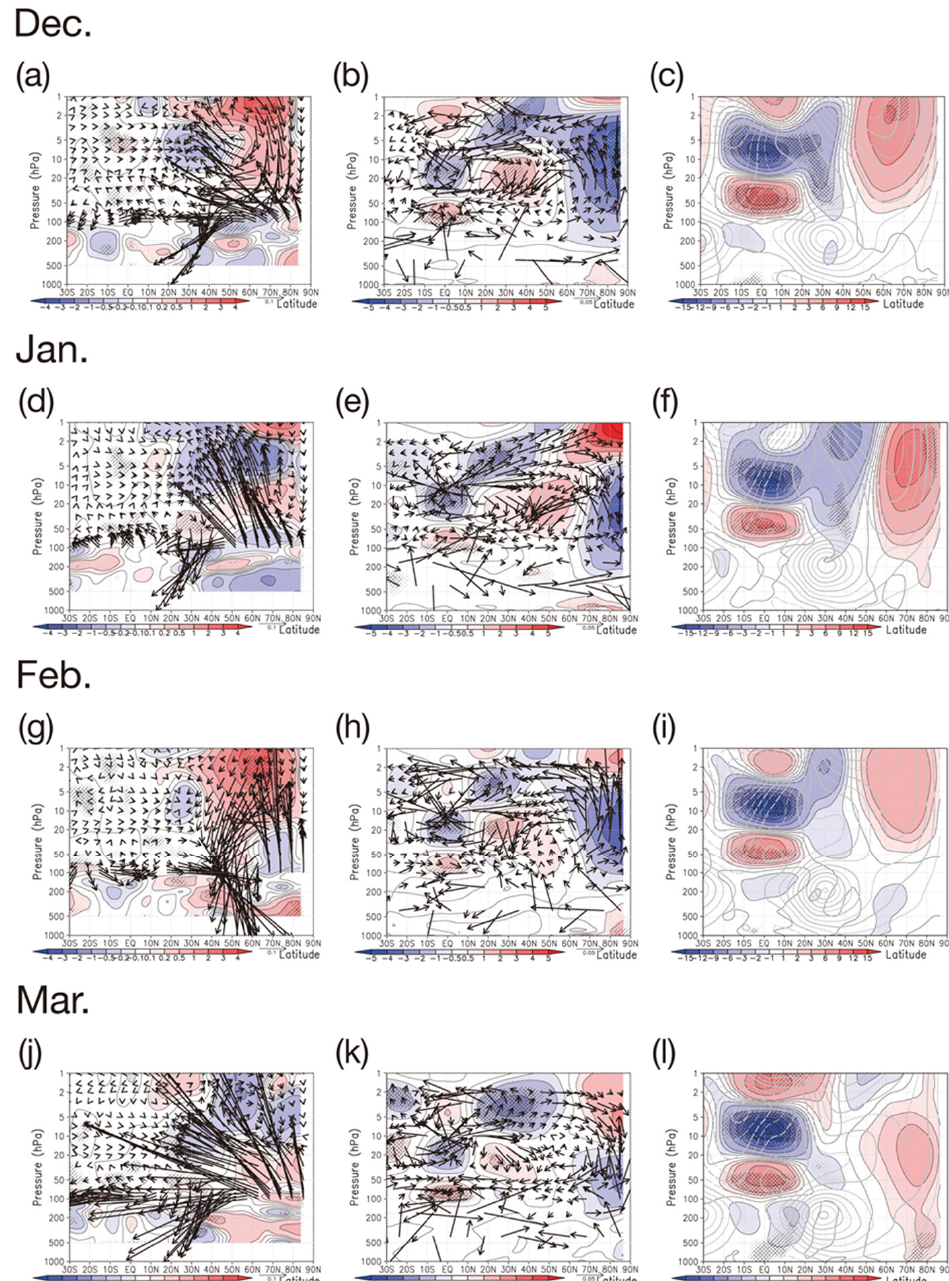
Figure 6. ( a ) Longitude–height section of composite anomalies for QBO-W/S min years from the December mean E-P flux (vector) and its divergence (shading, units: m s − 1 d − 1 ) from ERA-Interim. ( b ) Anomalies of the residual mean meridional circulation (vector) and temperature (shading, units: K). The vertical components of the E-P flux and the residual mean meridional circulation are magnified by a factor of 200 relative to the horizontal component, and their scales for the horizontal vector are shown at the bottom right of the panel in units of kg m − 1 s − 2 and m s − 1 , respectively. Nine-point smoothing was applied to the gridded data of the E-P flux, its divergence, and the residual mean meridional circulation. ( c ) Anomalies of the zonal-mean zonal wind (shading, units: m/s) with the zonal wind climatology (gray contour, interval is 5 m s − 1 ). The hatched areas with gray slash, gray grid, black slash, and black grid denote 80%, 85%, 90%, and 95% statistical significance, respectively, for the anomalies in the E-P flux divergence, temperature, and zonal wind. ( d – f ) for January, ( g – i ) for February, and ( j – l ) for March.